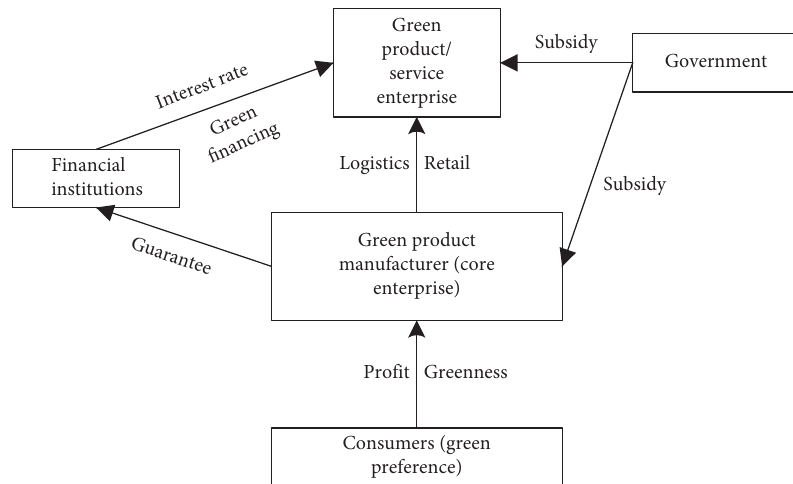
Figure 1: Financing flow of green enterprises with government